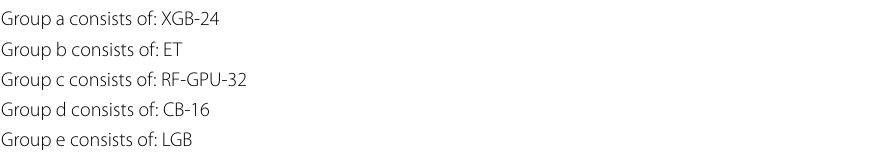
Table 27 HSD test groupings after ANOVA of AUC for the CLF factor